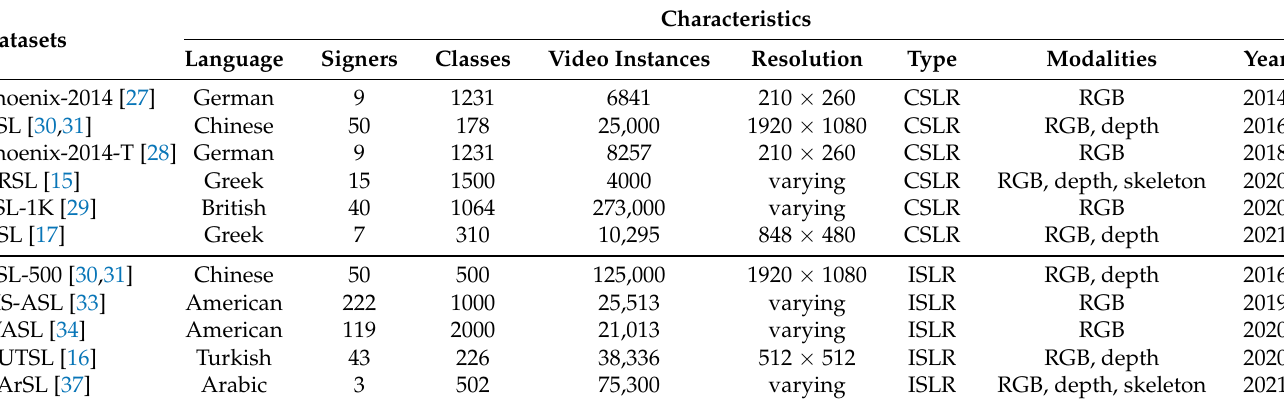
Table 1. Large-scale publicly available SLR